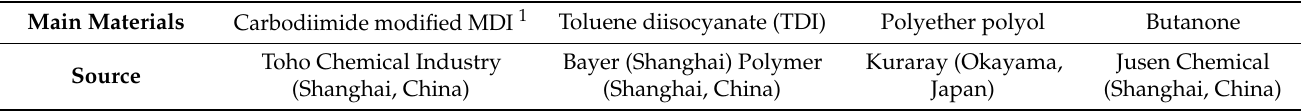
Table 1. The main materials used in the synthesis of